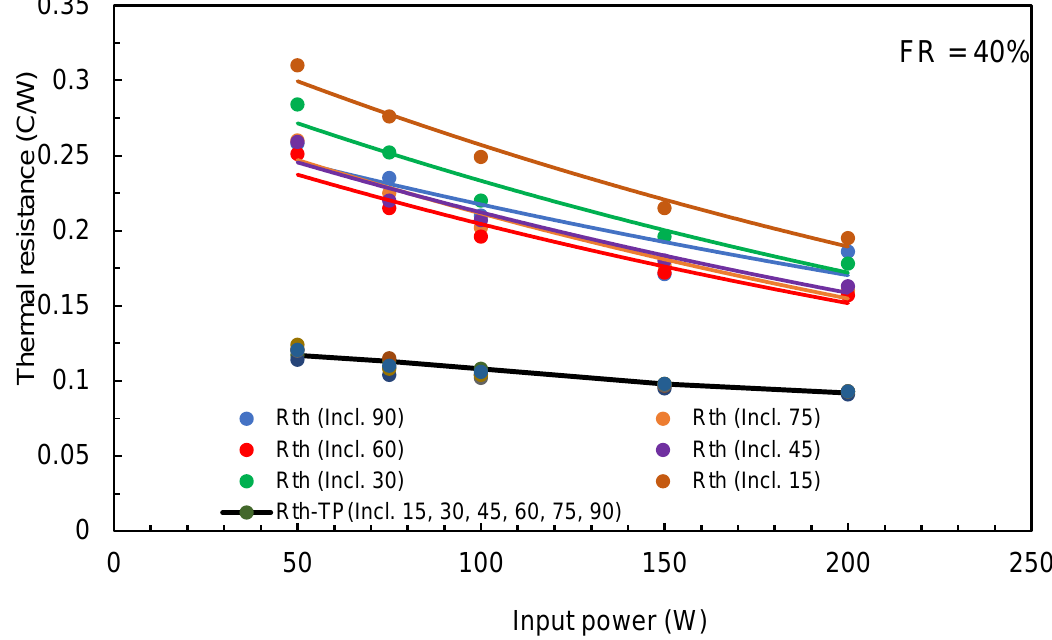
Figure 18. Variation of thermal resistance with input power for different inclination angles with and without TP (FR = 40%).